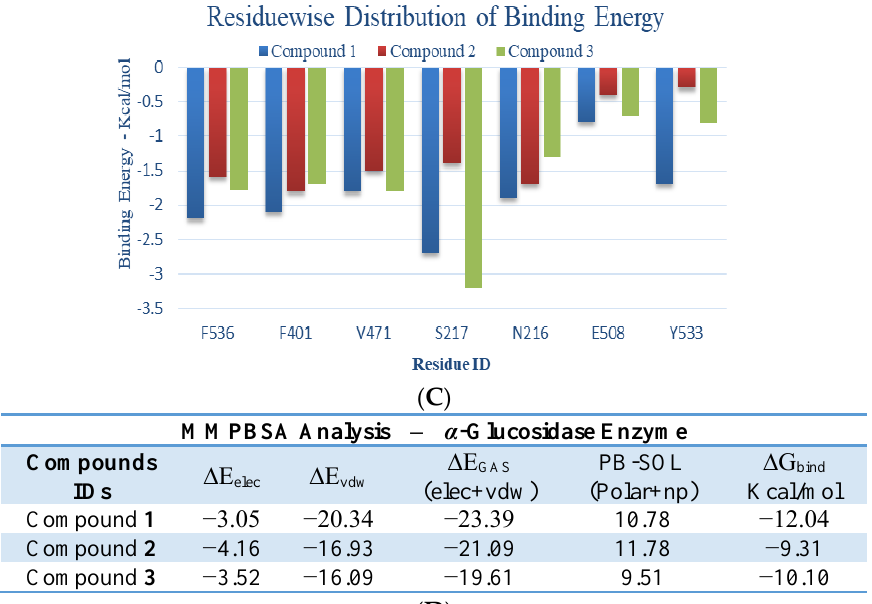
Figure 5. All atoms RMSD ( A ) and per residue RMSF plot ( B ) of α -glucosidase enzyme (PDB ID: 2JKE) in free and bound form with respect to initial minimized structures. Protein ligand complexes are color coded as Compound 1 (blue), Compound 2 (red), Compound 3 (green), Free protein (purple). ( C ) Major residues contributing towards protein ligand interactions. (All values are given in Kcal/mol) ( D ) Free energy of binding ∆ G bind for all compounds ( 1 , 2 and 3 ) using MMPBSA approach.